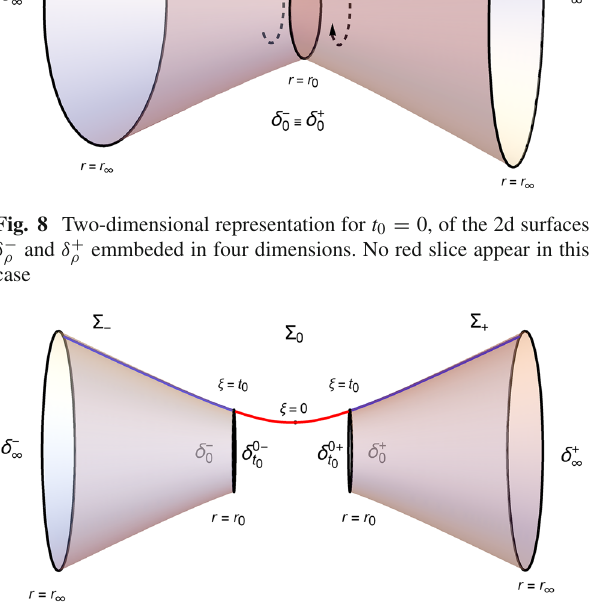
Fig. 9 Two-dimensional representation for t 0 (cid:8)= 0, of the 2d surfaces δ − δ + (cid:2) ρ and ρ , and the 0 slice emmbeded in four